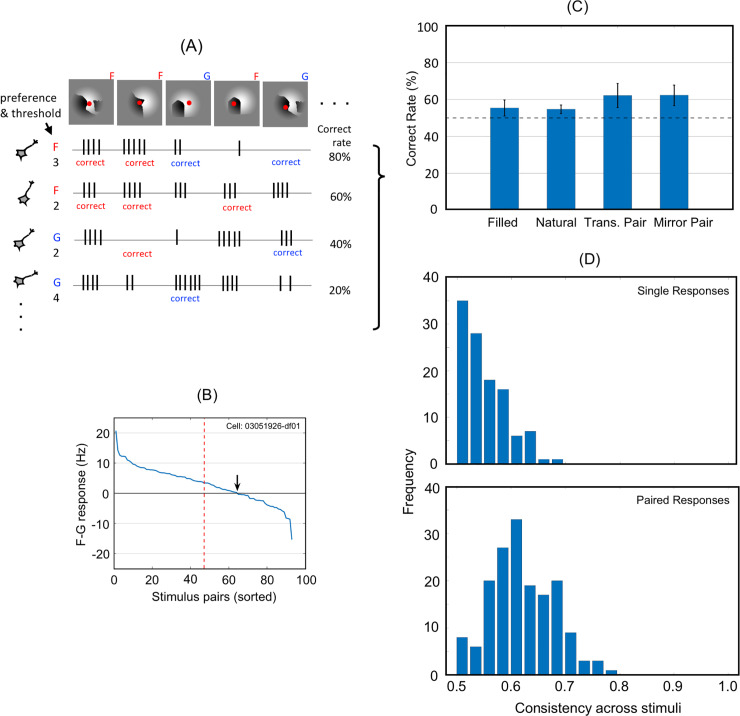
FG classification according to firing rates of single neurons.A: A schematic illustration showing the method to derive correct rates for single neurons from raw firing counts. This illustration shows four example neurons responding to five stimuli. The FG preference of a neuron was determined by the comparison between mean firing rates for figure and ground stimuli. A response to a stimulus is classified as correct if the response was greater than the threshold of the neuron when a preferred stimulus (the CRF center falls onto figure or ground) was presented. Similarly, a response is classified as correct if the response was smaller when a non-preferred stimulus was presented. The FG preference and threshold of the example neurons are indicated on the left side of the panel; F and G indicate the preference to figure and ground, respectively, and the numbers indicate the threshold in spike count. The spike trains below each stimulus illustrate the numbers of spikes as a response of the neurons to this stimulus. For example, the neuron at the top, which has preference to figure and threshold is three spikes/stimulus, showed four spikes to the left-most stimulus. This stimulus was preferred stimulus because the CRF center of this neuron (indicated by a red dot in the stimulus) fell onto figure (a white region in this stimulus). As the four spikes are greater than the threshold, this response is classified as correct. In this illustration, a total of five stimuli were presented, and the number of the correct responses of this neuron was four, so the correct rate of this neuron is 80%. B: The difference between the spike counts of figure and ground conditions for individual MPs in descending order. Data from an example neuron. Ninety-three pairs were usable for this neuron, where a figure region of one patch and a ground region of the mirrored patch fell onto the CRF center. The intersection of the curve with the abscissa (indicated by a black arrow) is shifted to the right of the center (a red dotted line) because the majority of patches produced stronger responses to figure than to ground. C: Mean correct rates across neuronal populations (193 FG-significant neurons). “Filled” and “Natural” indicate the stimulus types; rates were calculated from raw spiking activity. The correct rates for the differential responses were calculated from the responses to filled patches. Error bars indicate the standard error of the mean (SEM). D: The distributions of the correct rates (response consistency across the stimuli) were computed from single responses (top panel) and paired responses (bottom). Individual neurons barely discriminated FG across many stimuli.